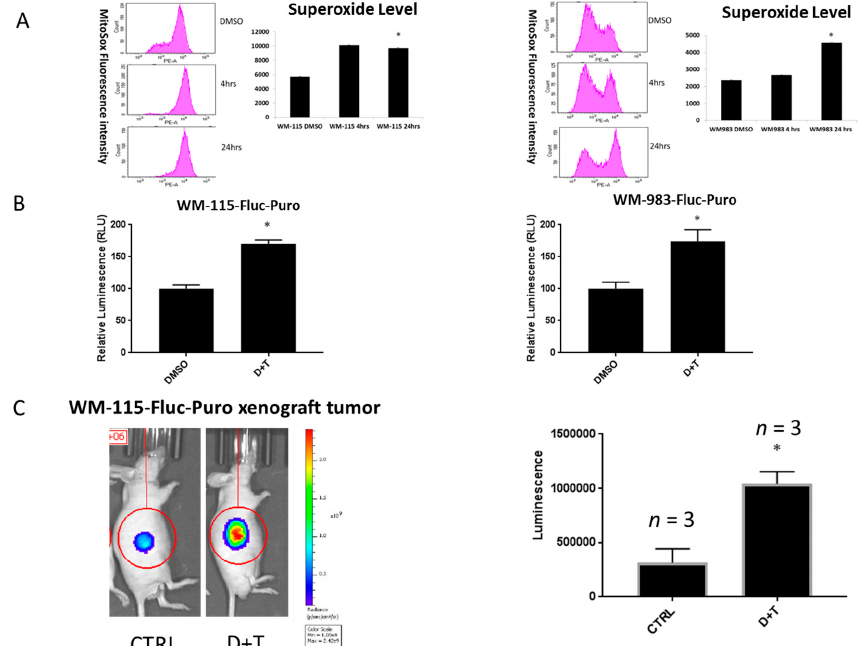
Figure 1. Reactive oxygen species (ROS) level is upregulated upon BRAF pathway inhibitor treatment. ( A ) WM-115 and WM-983 cell lines were treated with 2.4 μ M dabrafenib and 500 nM trametinib.